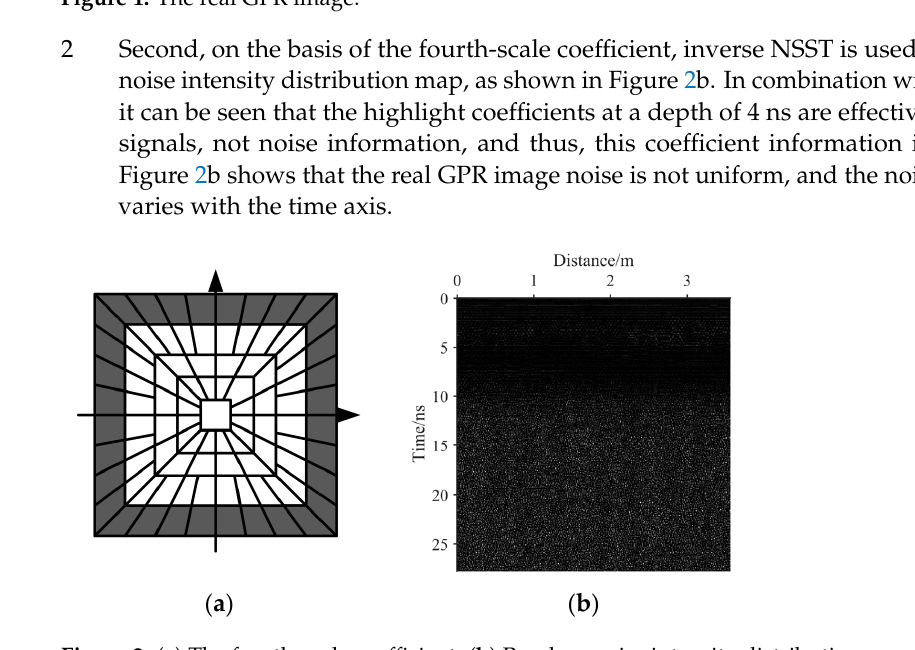
Figure 2. ( a ) The fourth-scale coefficient. ( b ) Random noise intensity distribution map.